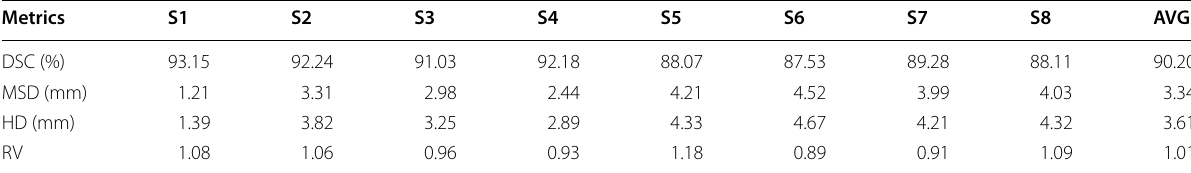
Table 2 Quantitative evaluation for automated liver segment segmentation.